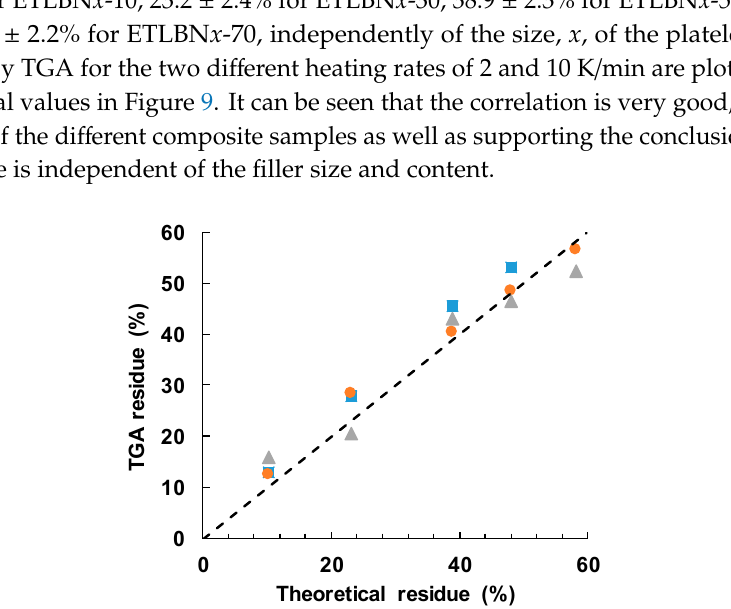
Figure 8. TGA curves of sample mass versus temperature for the fully cured ETLBN30- y system at 10 K/min in an inert atmosphere: dash-dotted, green, y =0; dotted, blue, y =30; short dash, pink, y =50; long dash, red, y =60; full line, purple, y =70.